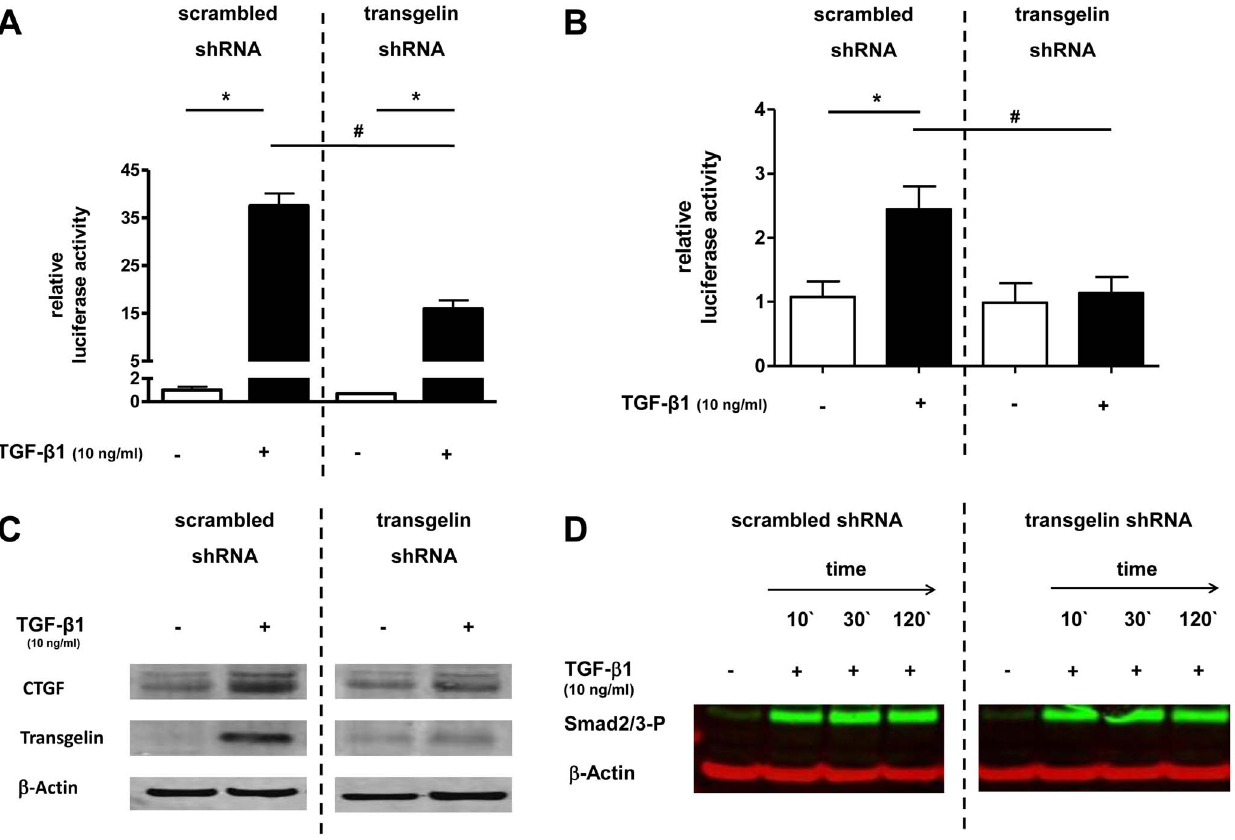
Figure 6. Effect of transgelin silencing on Smad signalling in lung epithelial cells. Transgelin was down-regulated by transgelin-specific shRNA (right side;’’transgelin shRNA’’) and compared with control cells, which were expressing non-specific shRNA (left side; ‘‘control shRNA’’). A + B . After down-regulation of transgelin by specific shRNA, the TGF- b 1–sensitive (CAGA) 12 -luciferase construct (A) or the p3TP-luciferase construct (B) were transiently transfected into A549 cells. Cells were then treated with or without TGF- b 1 (10 ng/ml). Firefly luciferase activity was normalized to the activity of Renilla luciferase under control of the thymidine kinase promoter. * p , 0.05 compared to control cells, # p , 0.05 compared to ‘‘control shRNA’’. C . Cells were incubated with TGF- b 1 (10 ng/ml) and 48 h later Western blot analysis of CTGF, transgelin, and b -actin was performed. A representative immunoblot of at least three independent experiments is shown. D . Phosphorylation of endogenous Smad2/3 protein. A549 cells were stimulated with TGF- b 1 (10 ng/ml) for 10, 30, or 120 minutes. Smad2/3 phosphorylation was detected by immunoblotting with anti-phospho- Smad2/3 antibodies. A representative immunoblot of 3 independent experiments is shown.